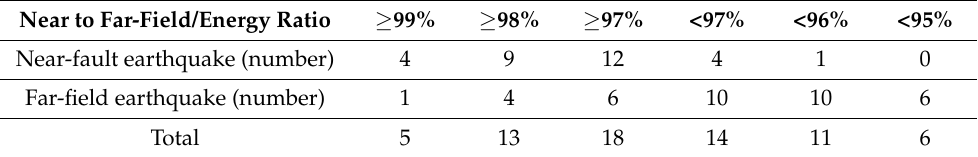
Table 3. Near-fault and far-field earthquake numbers of different energy